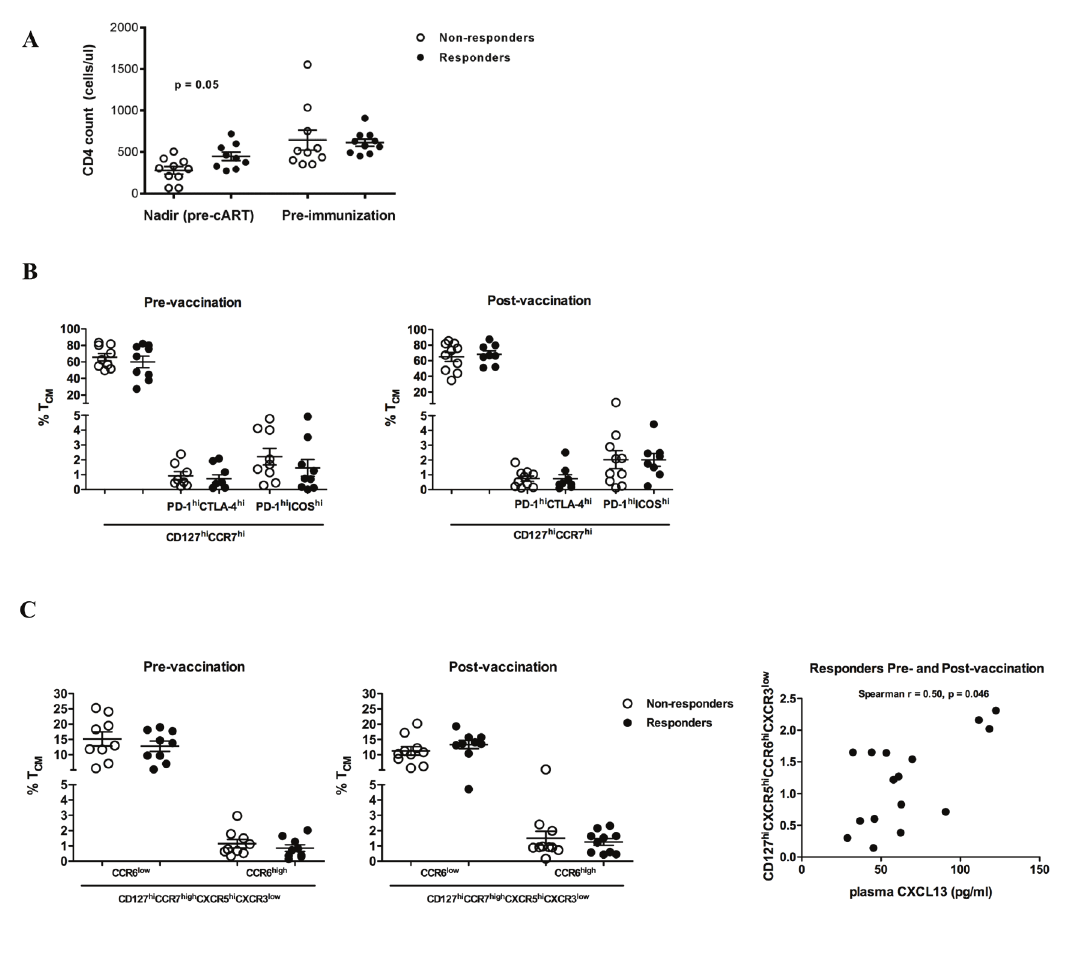
Figure 3. Circulating pTfh subpopulations correlate with plasma levels of CXCL-13 in HBV vaccine responders. (A) Absolute counts of CD4 T cells in non-responders and responders pre-vaccination are shown, (B) pooled data showing the relative frequencies of “activated” central memory CD127 high CCR7 high CD4 T-cell subpopulations in non-responders and responders pre- and post-vaccination, (C) Pooled data showing the relative frequencies of central memory CD27 high CD45RA high CD127 high CCR7 high CD4 T-cell populations with respect to expression of CCR6 ( left panel ) and the correlation between CCR6 high pTfh cells and plasma levels of CXCL-13 is shown for vaccine responders ( right panel ). Scatterplots with mean and SEM denoted with statistical analysis performed using Mann-Whitney U test. Correlations with P -val- ues determined using Spearman’s rank